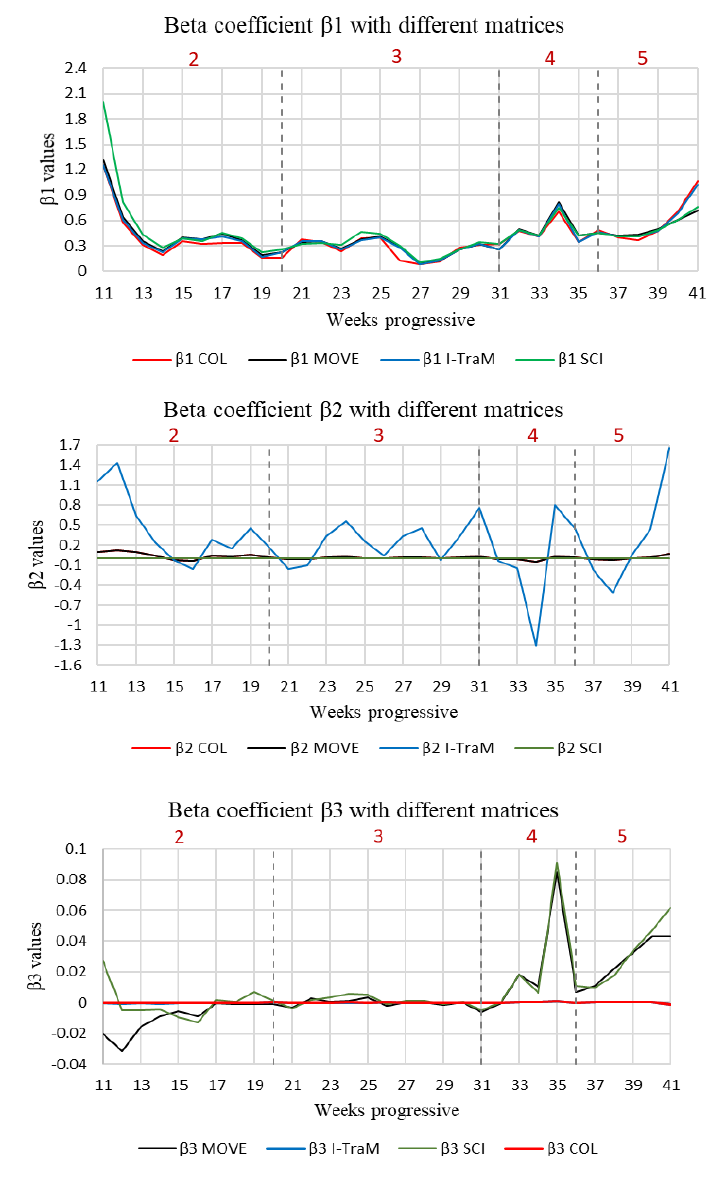
Figure 13 The comparison of beta-coefficients of the equations with different mobility matrixes Colocation (11), Movements (12), SCI (13), i-TraM